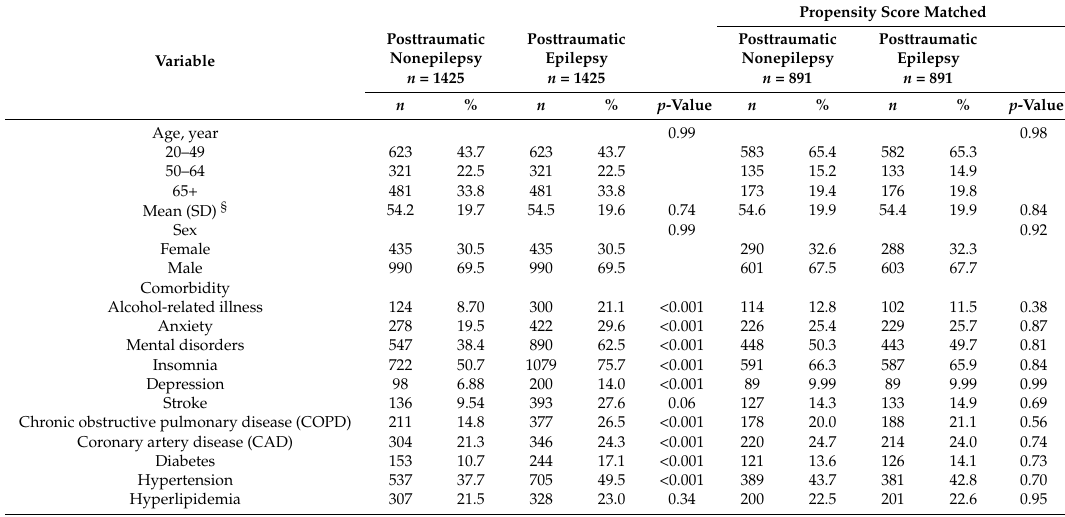
Table 1. Distribution of age, sex, and comorbidity in PTE (posttraumatic epilepsy) and PTN (posttraumatic nonepilepsy) cohorts with and without propensity-score